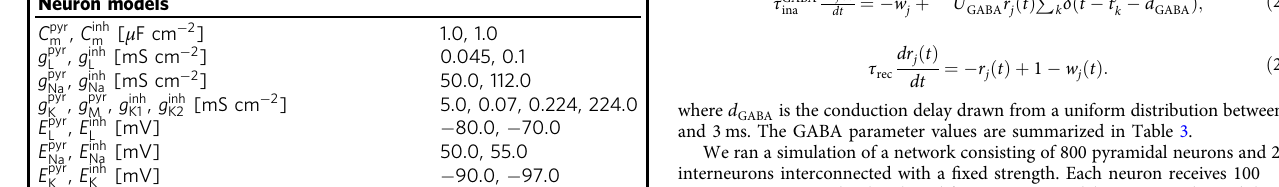
Table 2 Parameters for pyramidal neurons and interneurons Neuron models